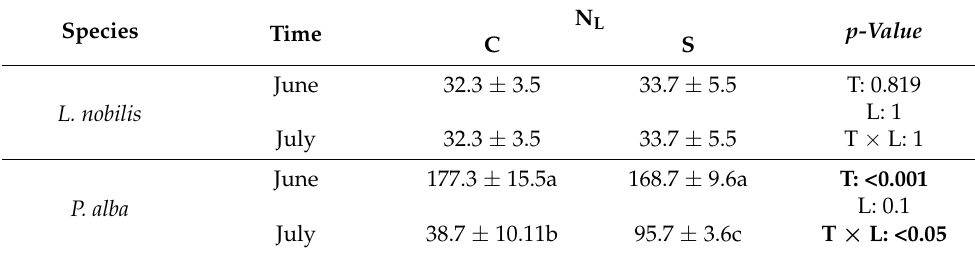
Table 2. Mean ± SEM (n = 3 plants) of total number of leaves (N L ) as recorded in June (before starting drought treatment) and in July (at the end of the experimental period, for details, see the text). Different letters indicate statistically significant differences based on two-way ANOVA. F values are reported as resulted by statistical analysis of N L measurements by time, T (i.e., June, before drought, and July, at the end of experimental treatment) and light treatment, L (i.e., control and shaded